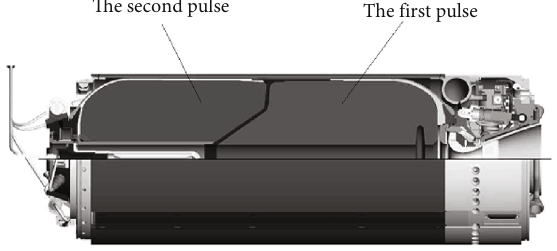
Figure 1: Soft PSD double-pulse